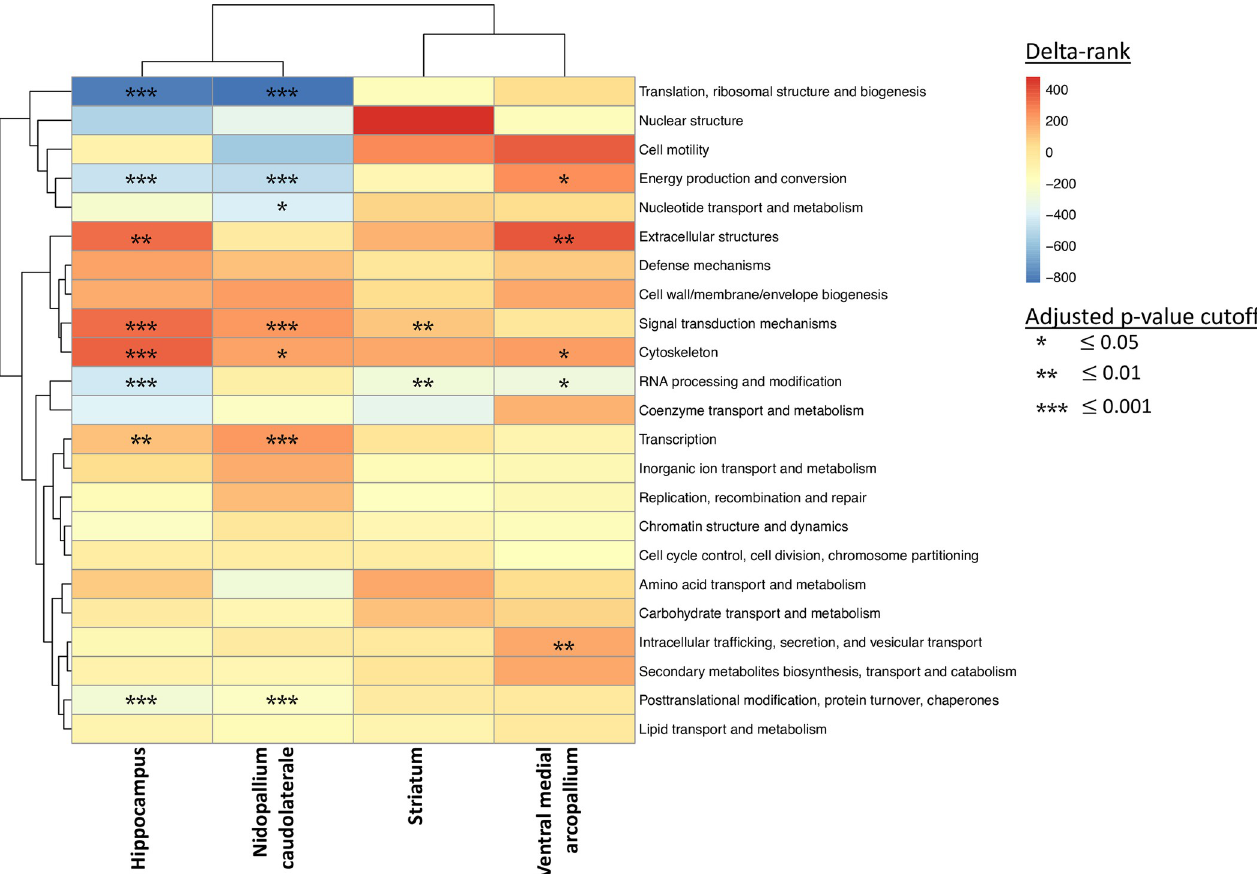
Fig 4. Enriched eukaryotic orthologous group (KOG) terms in the house sparrow transcriptome across four brain regions. Positive delta-ranks (red) are associated with upregulation in neophobic birds relative to non-neophobic birds, and significance is based on Benjamini-Hochberg adjusted p-values (FDR).